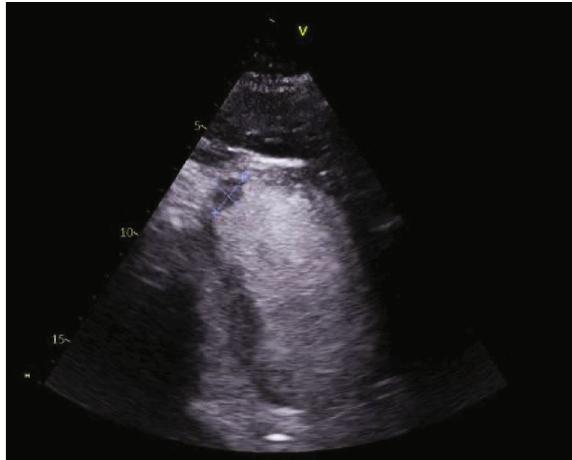
Figure 3: Contrast-enhanced transthoracic echocardiogram. Contrast ECHO demonstrating the left ventricular